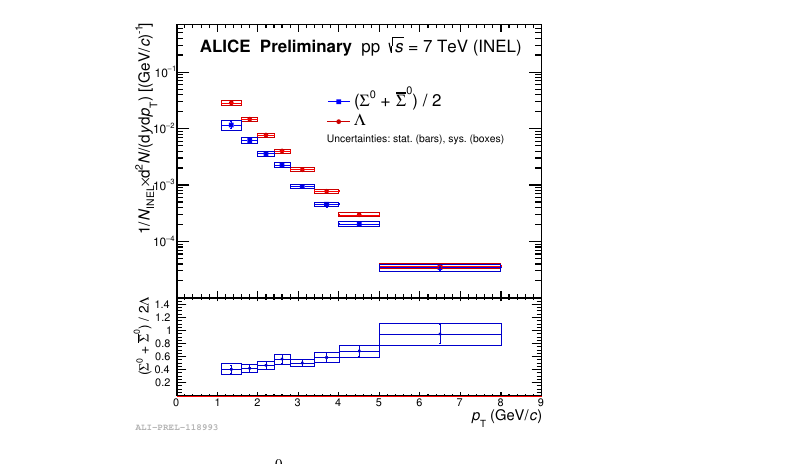
Figure 4. The di ff erential yields of ( Σ 0 + Σ di ff erential yield ratios of ( Σ 0 + Σ